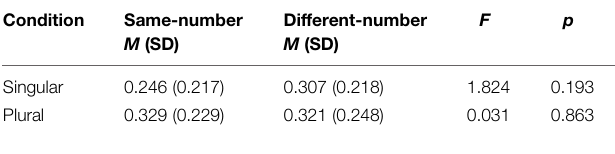
TABLE 5 | Experiment 3 anticipatory eye movement